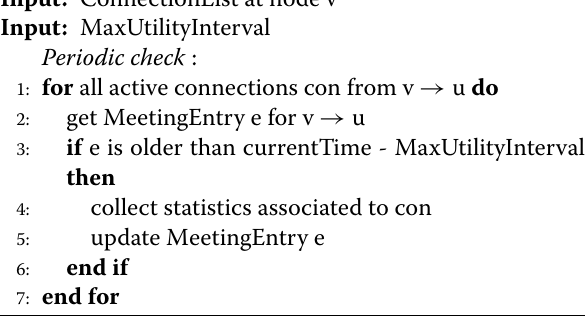
In variant 2, all nodes of the backbone have been replaced by one single, virtual node. Afterwards, con- nections overlapping in time, arising from this process,